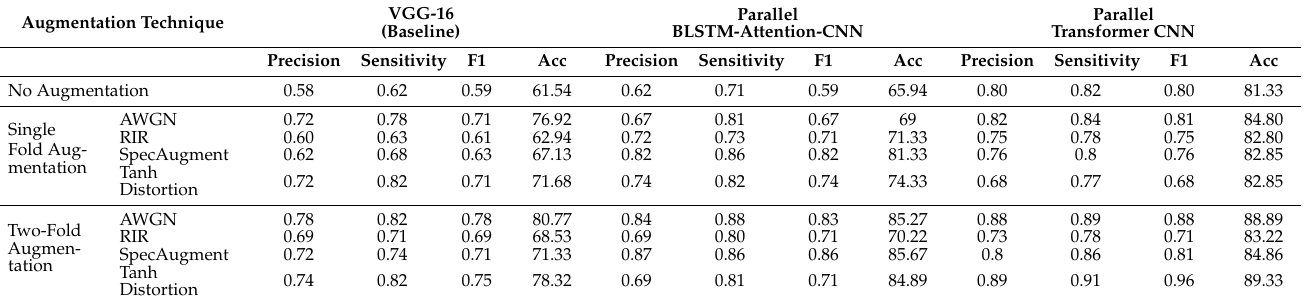
Table 6. Weighted average precision, sensitivity, F1 score, and accuracy of each model augmented with different augmentation techniques on test